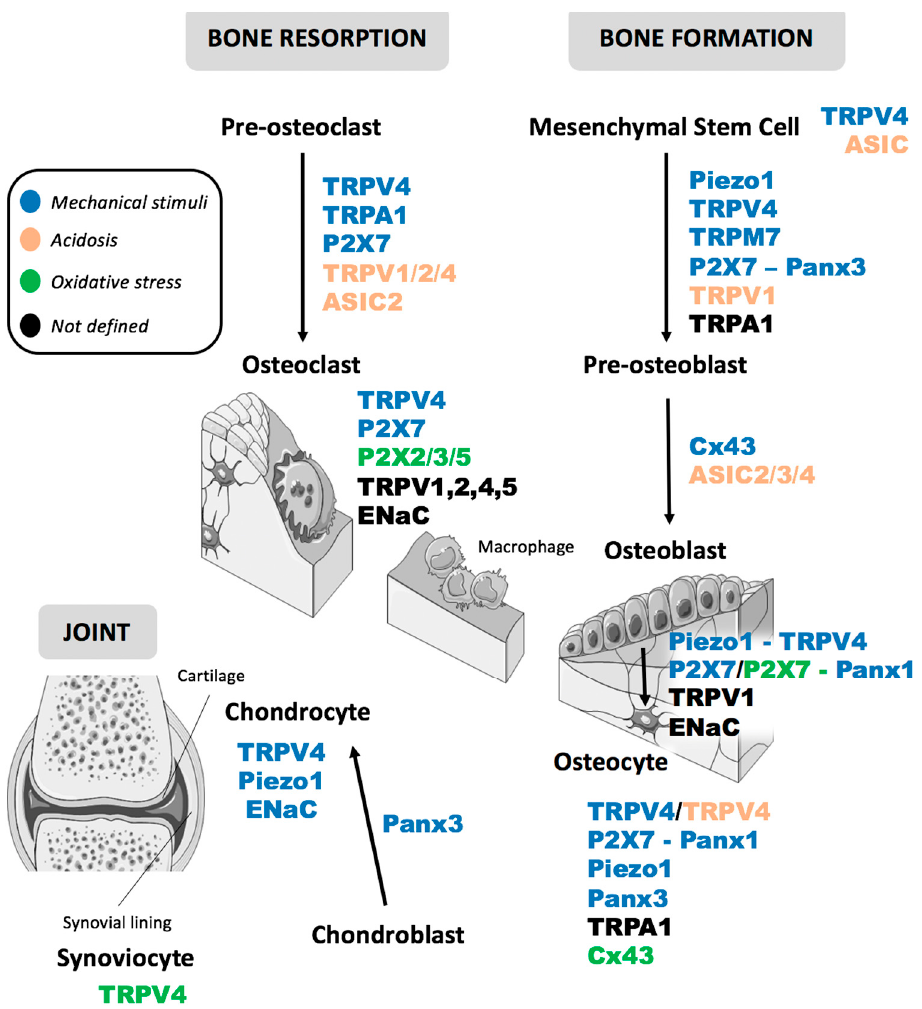
Figure 1. Schematic representation of the main plasma membrane channels involved in different phases of bone remodeling; the main stressors involved in their activation are represented by a color code as reported in the legend. The Figure was partly generated using Servier Medical Art, provided by Servier, licensed under a Creative Commons Attribution 3.0 unported license. Table 1. List of the plasma membrane ion channels involved in bone remodeling and their role in physio-pathological processes; ↑ : increased , ↓ : decreased. OS: Oxidative Stress. MSC: Mesenchymal Stem Cells, CAF: Cancer Associated Fibroblasts, mpkCCDc14: mouse cortical collecting duct cells.